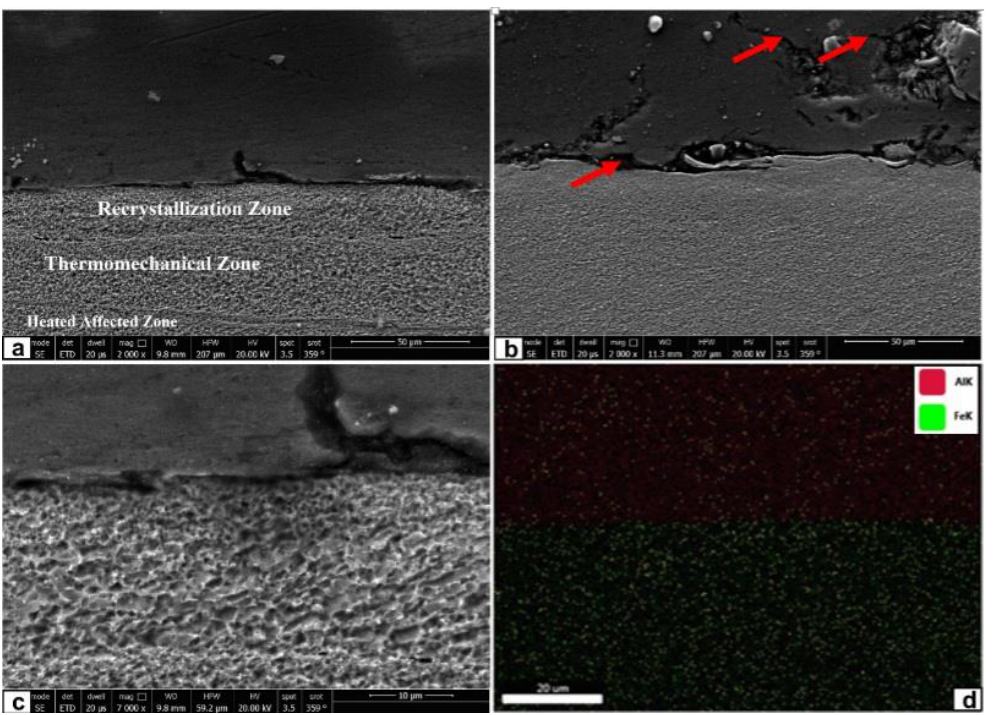
Figure 10. SEM Micrographs of the aluminum/steel interface produced with low FSP rotation speed of 500 rpm and pin length of 3.2 mm: ( a ) steel – aluminum interface, ( b ) cavities and cracks around the steel fragments, ( c ) microsturcture of the steel side, and ( d ) EDS mapping of ( c ).